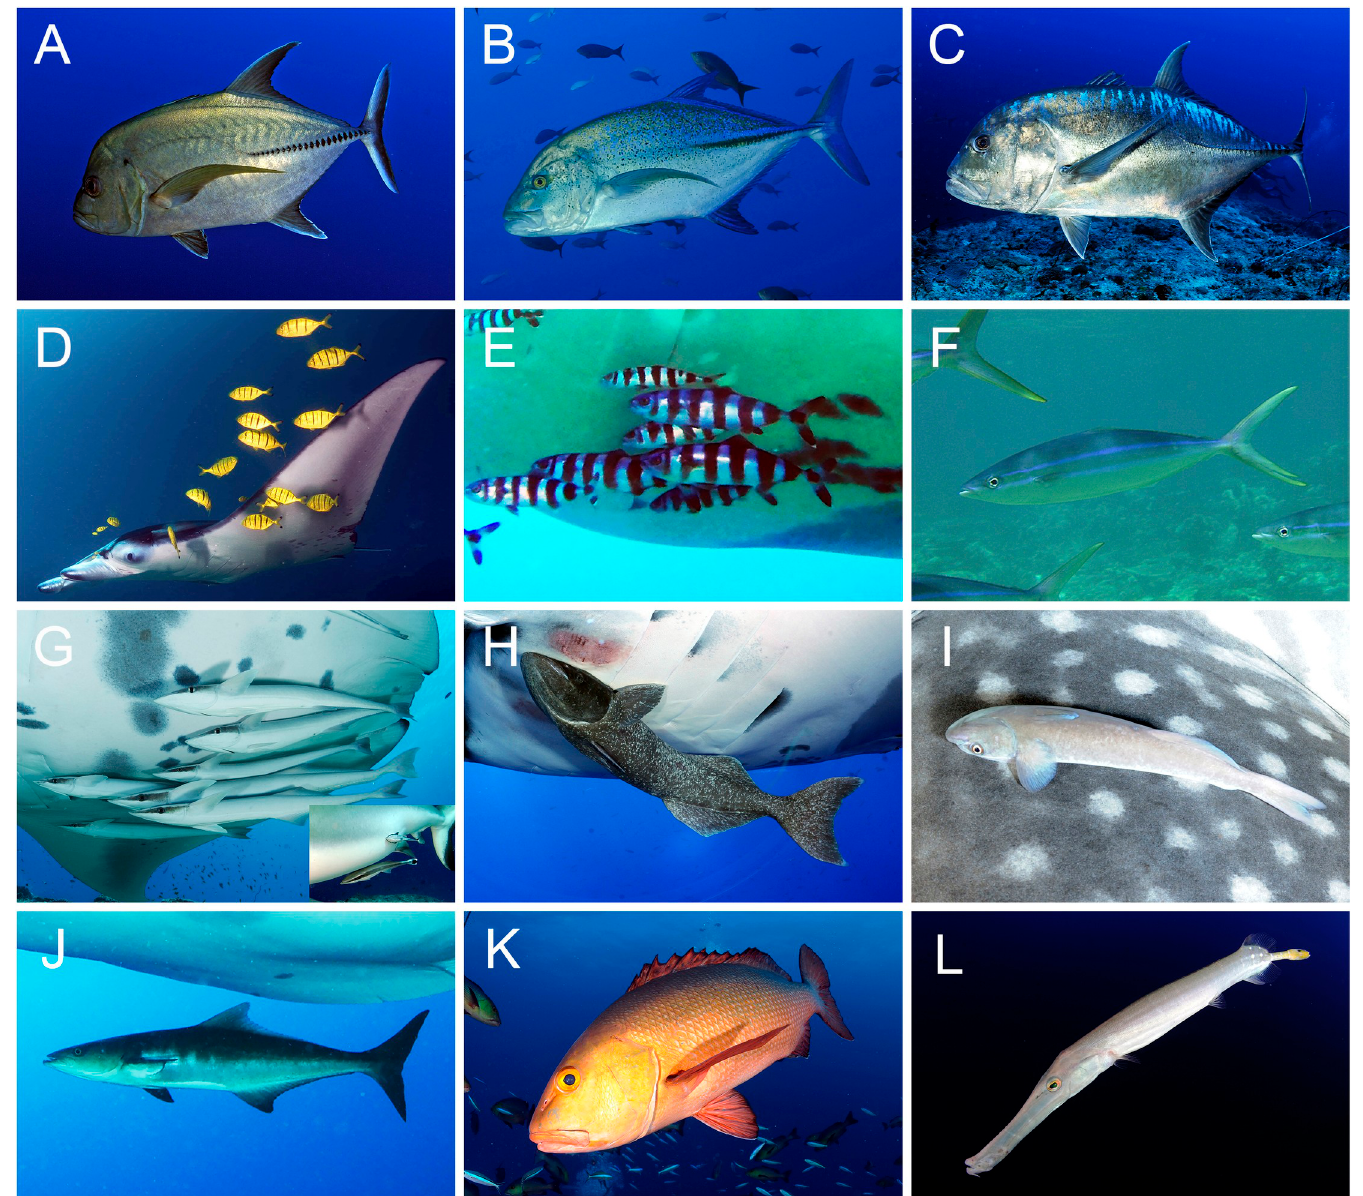
Fig 2. Images of hitchhiker species used for identification. (A) black trevally ( Caranx lugubris ), (B) bluefin trevally ( Caranx melampygus ), (C) giant trevally ( Caranx ignobilis ), (D) golden trevally ( Gnathanodon speciosus ), (E) pilot fish ( Naucrates doctor ), (F) rainbow runner ( Elagatis bipinnulata ), (G) sharksucker remora ( Echeneis naucrates ) (juvenile inset), (H) giant remora ( Remora remora ), (I) little remora ( Remora albescens ), (J) cobia ( Rachycentron canadum ), (K) red snapper ( Lutjanus bohar ), and (L) Chinese trumpetfish ( Aulostomus chinensis ). All images © The Manta Trust.